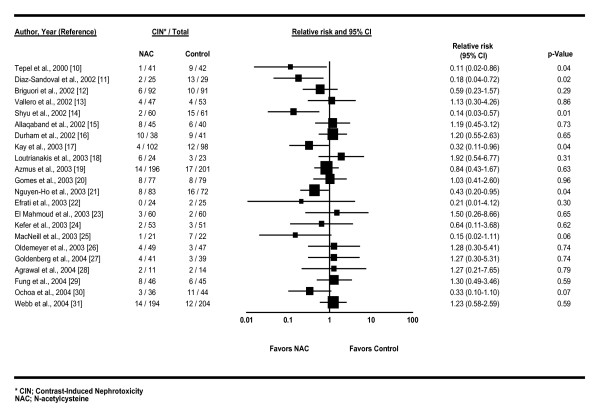
Forest plot of twenty-two studies meeting inclusion criteria for meta-analysis. Studies are ordered by date of publication. Lines represent 95% CIs. Box sizes represent the weight (by inverse variance) of each trial. Note a trend over time towards no effect. No summary statistic is shown owing to excessive heterogeneity.